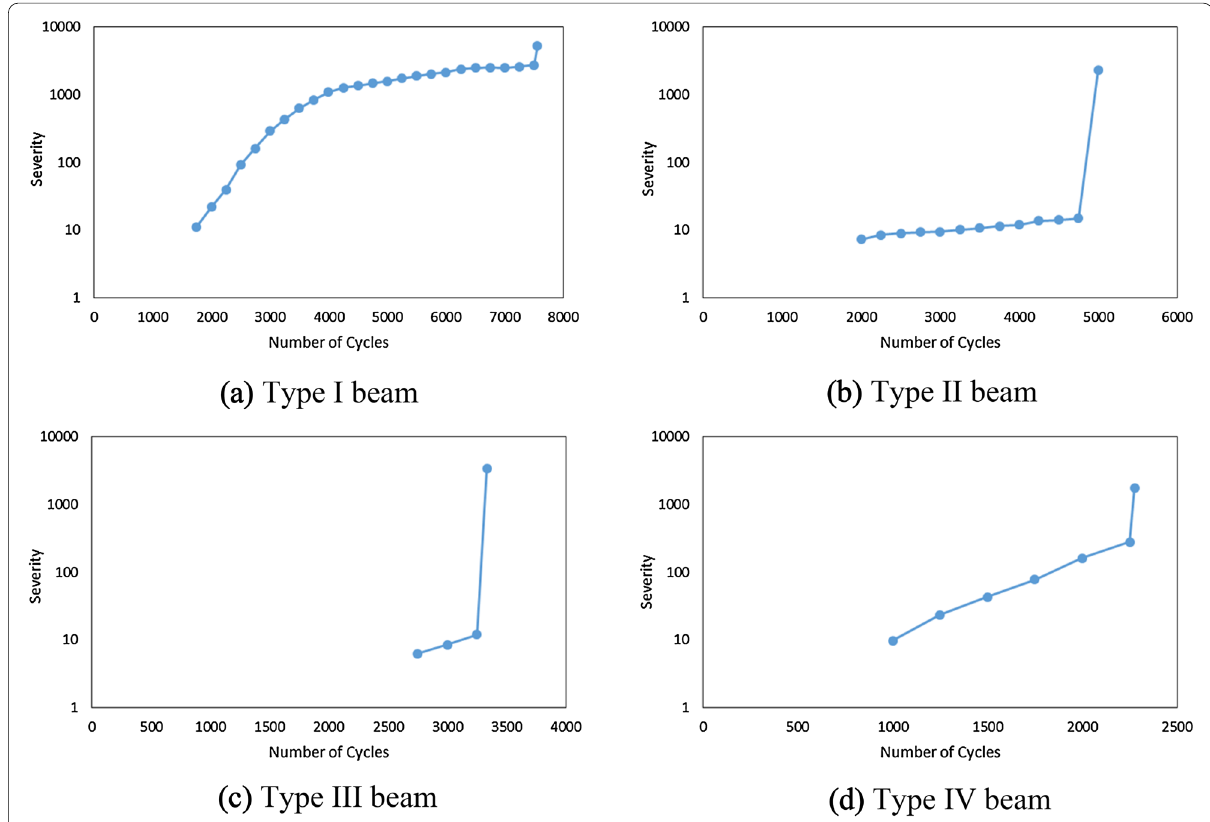
Fig. 9 Severity versus the number of cycles.